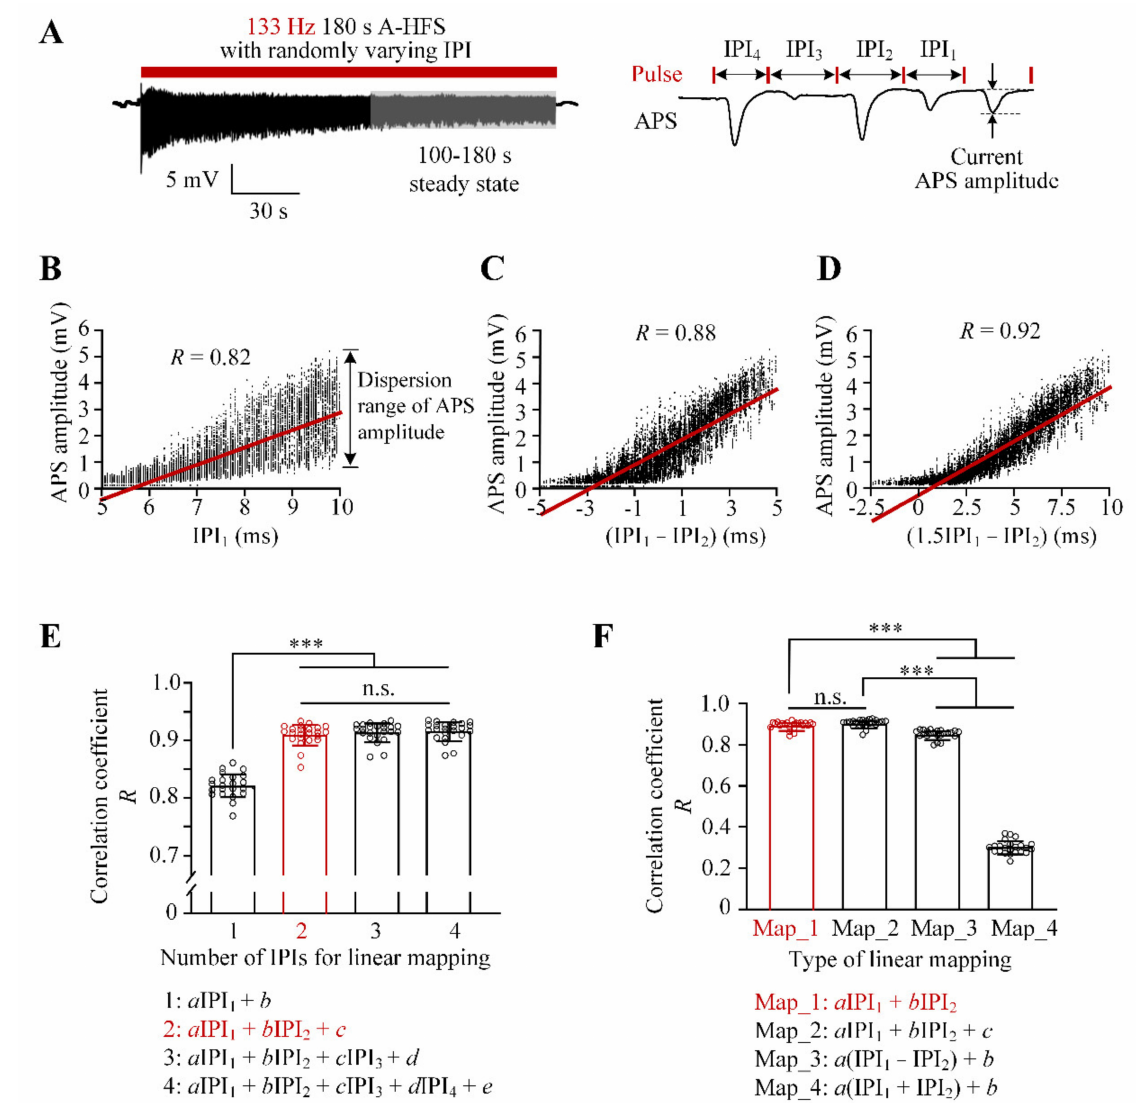
Figure 2. Comparison of different mapping models describing the relationship between the amplitudes of evoked APS and the preceding IPIs. ( A ) Left : evoked APS during an A-HFS sequence with uniformly varying IPI. Right : illustration of the current APS and its preceding IPIs (IPI 1 , IPI 2 , IPI 3 and IPI 4 ). ( B – D ) Examples of the correlations of APS amplitudes to IPI 1 , (IPI 1 − IPI 2 ) and (1.5IPI 1 − IPI 2 ) with their correlation coefficient ( R ), respectively. The APS amplitudes were collected from the 100–180 s steady-state period of A-HFS shown in ( A ). ( E ) Comparison of the R values for the linear mappings of APS amplitudes with different numbers of preceding IPIs. ( F ) Comparison of the R values for the different types of linear mappings with the two preceding IPIs (IPI 1 and IPI 2 ). *** p < 0.001; n.s., not significant; post hoc Bonferroni tests after ANOVA for the data from n = 23